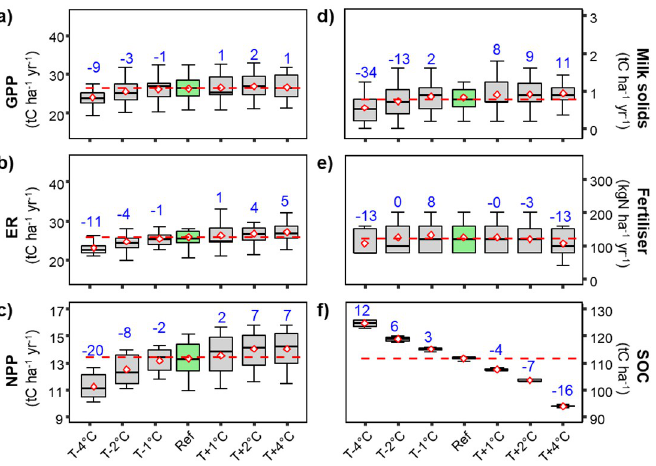
Fig 1. Box and whiskers charts for modelled variables under a range of different temperatures. Shown are modelled GPP a, ER b), NPP c), Milk-solid production d), required N fertilizer application rates), and SOC stocks f) in response to changes in air temperature for the grazed grassland site. Horizontal red dashed lines are the means of the variables for the reference period and blue numbers give the percentage changes of the variable means under the different changed meteorological conditions. The horizontal line within the boxes gives the median of observed values, diamonds give the averages, upper and lower sides of the boxes give the interquartile range between the 25 th and 75 th percentiles and the whiskers give the largest and lowest